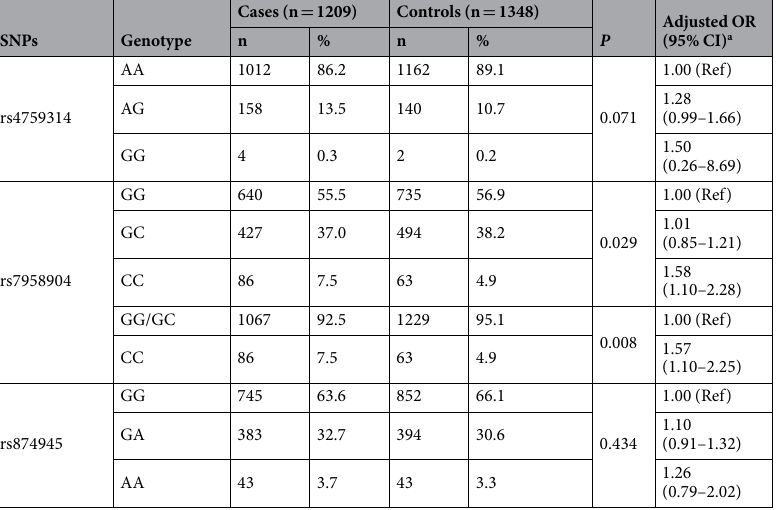
Table 1. Association of HOTAIR SNPs with risk of CC. a Adjusted for age, parity, and menopausal status in logistic regression model.